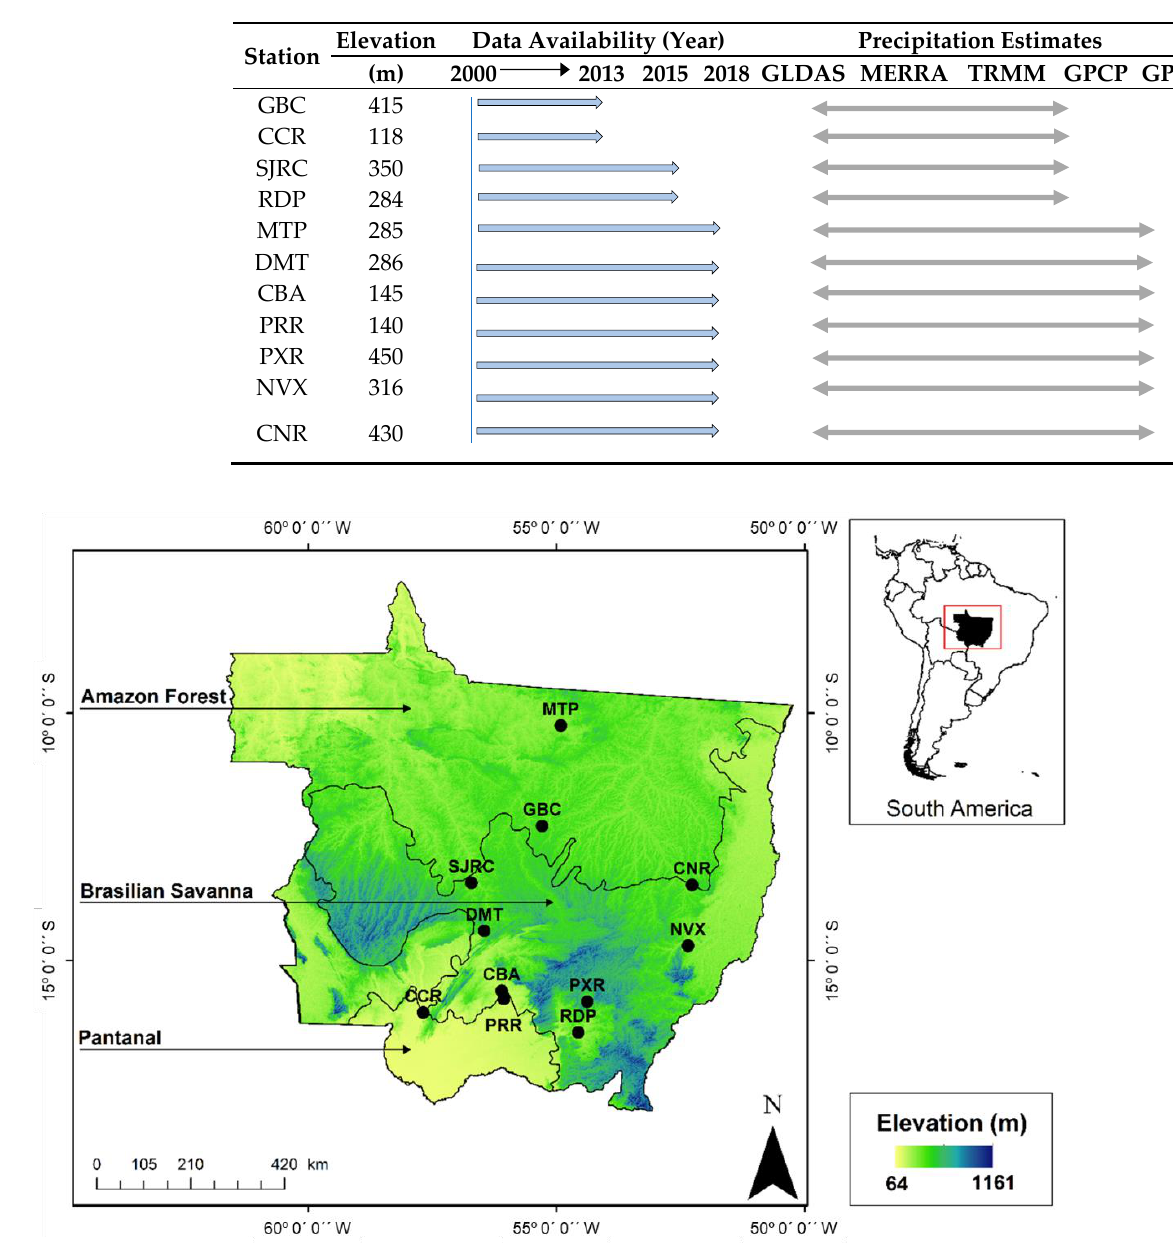
Figure 1. Distribution of conventional weather stations in the state of Mato Grosso, Brazil along with the ground surface elevation and the distribution of the biomes (Amazon Forest, Brazilian Savanna, and Pantanal).